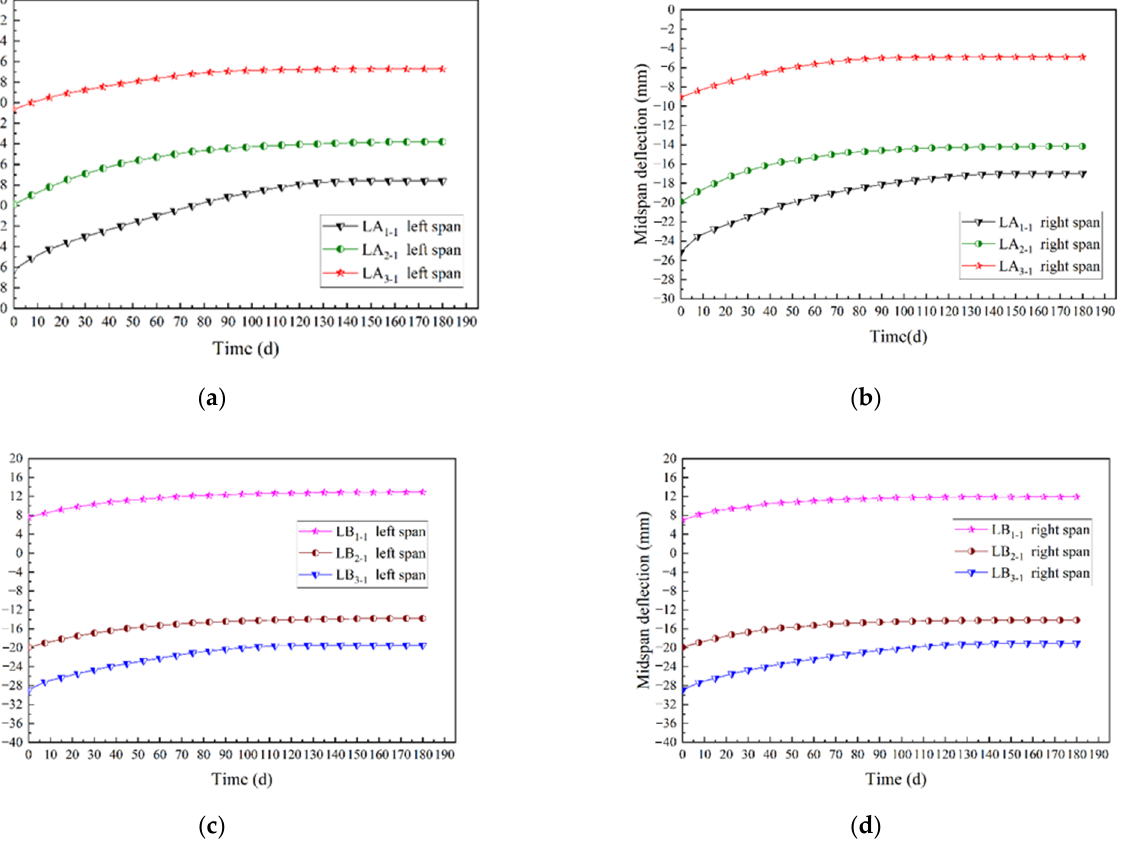
Figure 12. Time-varying curves of midspan deflection: ( a ) Left span of group A (different steel wires quantities); ( b ) right span of group A (different steel wires quantities); ( c ) left span of group B (dif- ferent prestress values); ( d ) right span of group B (different prestress values).